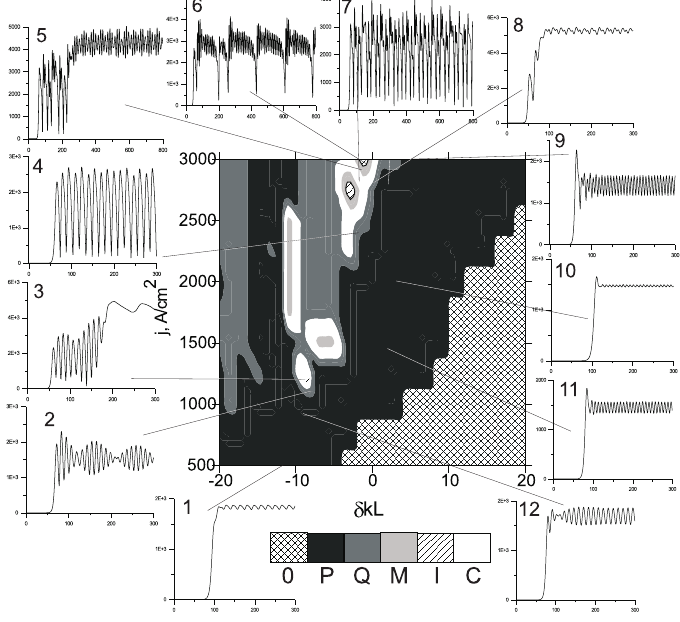
Figure 5. Two-parametric maps of chaotic lasing for diffracted wave. Notation is the same as in Fig.4.